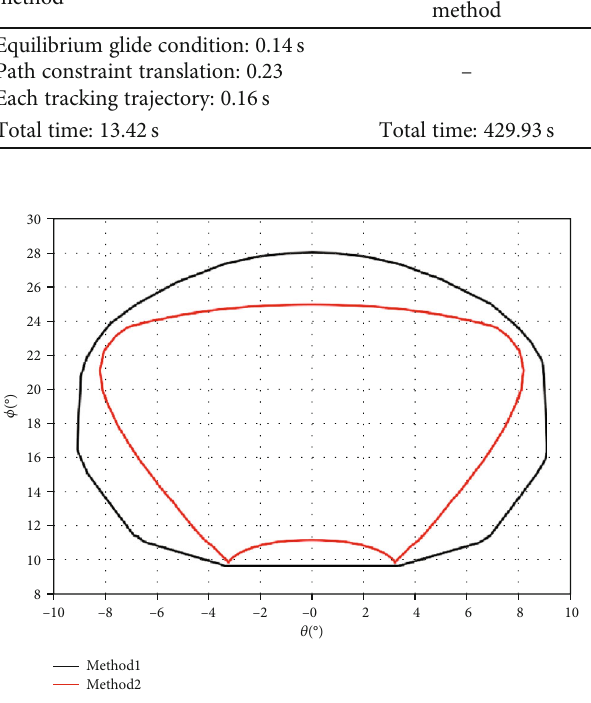
Figure 16: Landing footprints for Case 1 (method 1: the Gauss pseudospectral method; 2: the EAGLE